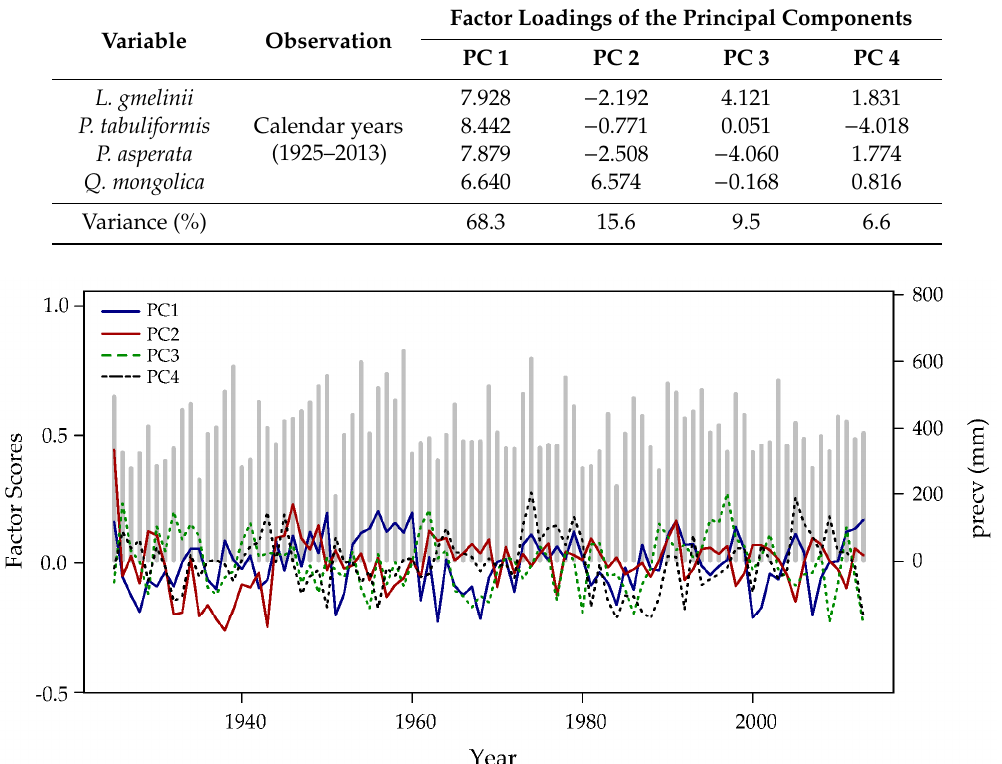
Figure A1. Principal components analysis (PCA): Factor Scores of the four principal components (coloured lines) and precipitation sum during the vegetation period (precv, bars) covering the 1925 to 2013 time span.